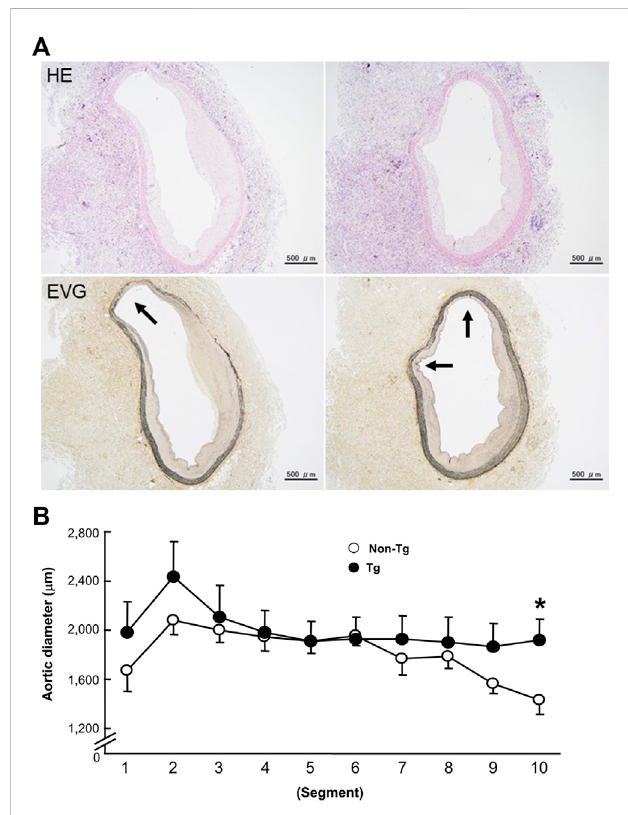
FIGURE 4 Representative micrographs of the focal dilation in the abdominal aortas of Tg rabbits (A) and quantitation of aortic dilation (B) . A: The lesions were stained with either H&E or EVG. Arrows indicate the protruded lumens. B: The aortic dilation was evaluated by measuring a de fi ned area of the internal elastic lamina and calculating the diameter in each segment of the aorta. The data were expressed as the mean ± SE ( n = 12 for each group). * p < .05 vs.